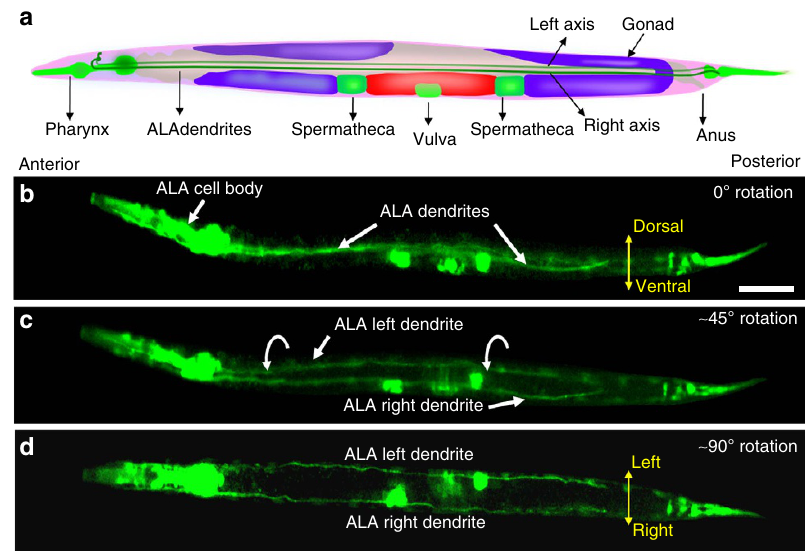
Figure 7 | Observations of the anatomy of ALA neuron dendrites using rotational orientation. ( a ) A schematic of C. elegans showing the anatomy of ALA cell body and dendrites. ( b ) Fluorescence image of a C. elegans showing overlapped, masked ALA dendrites at the dorsoventral axis. The worm is rotated ( c ) B 45 (cid:2) and ( d ) B 90 (cid:2) simultaneously exposing the left and right dendrites for observation. Scale bar, 40 m